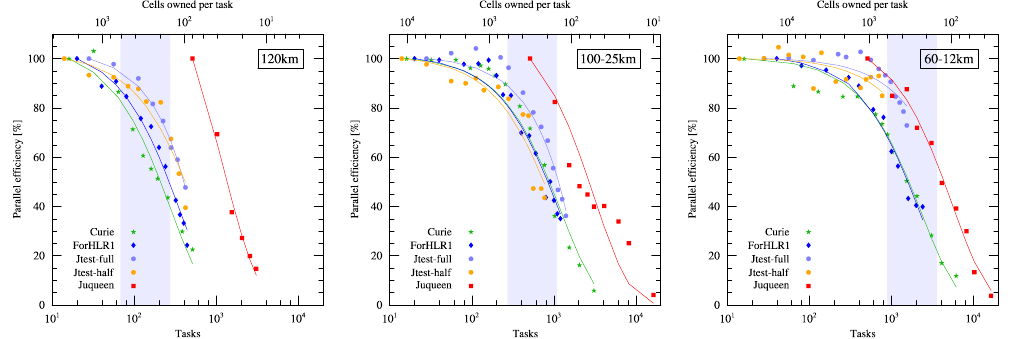
Figure 2. Parallel efficiency (%) for the 120km regular mesh with 40962 grid cells, the variable 100–25km mesh with 163842 grid cells and the variable 60–12km mesh with 535554 grid